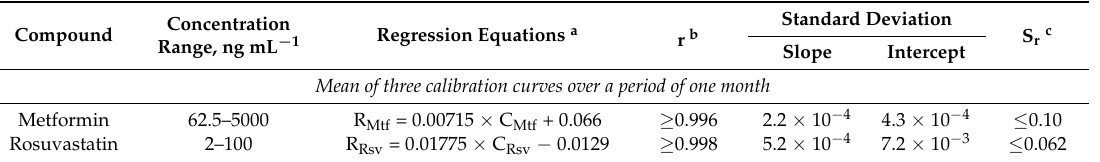
Table 1. Analytical concentration parameters of the calibration equations for the determination of metformin and rosuvastatin in human plasma by